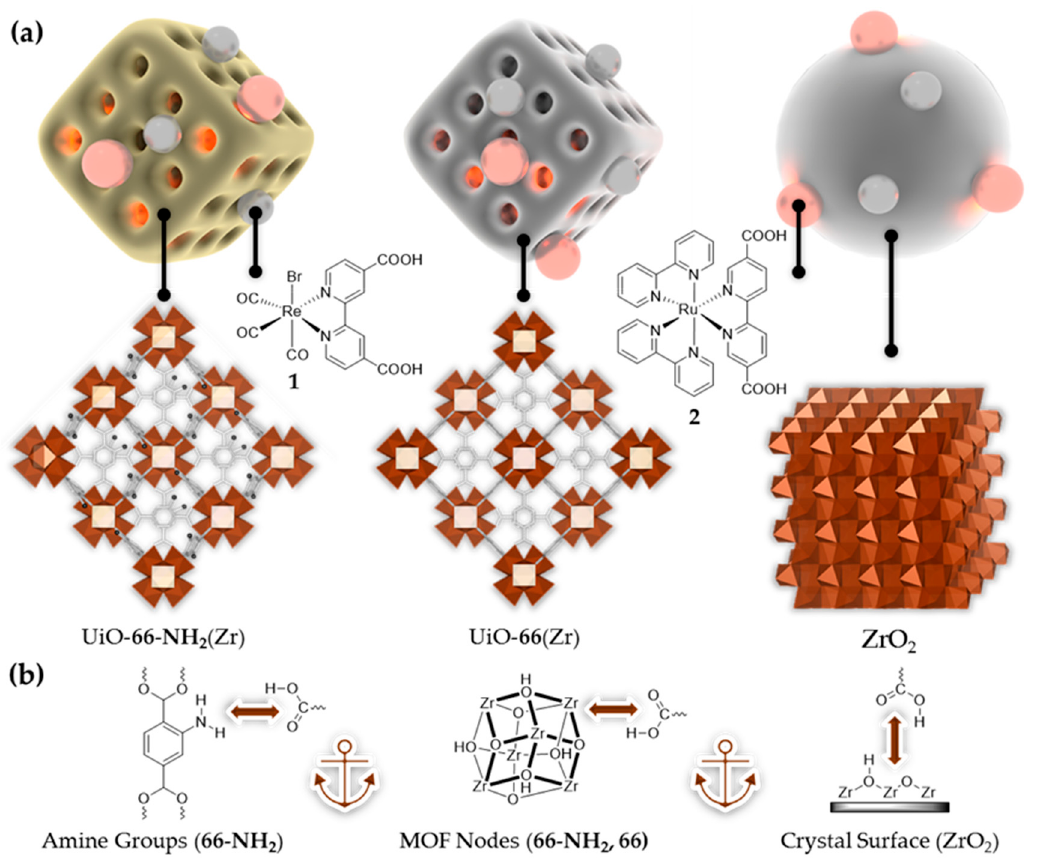
Figure 1. Schematic overview of the studied hosts and molecular complexes. ( a ) Representation of the porous MOF hosts UiO-66-NH 2 (Zr) ( 66-NH 2 ) and UiO-66(Zr) ( 66 ), as well as monoclinic ZrO 2 nanoparticles. Chemical structures of the molecular photocatalyst fac -ReBr(CO) 3 (4,4 ′ -dcbpy) ( 1 ) and the [Ru(bpy) 2 (5,5 ′ -dcbpy)]Cl 2 photosensitizer ( 2 ). ( b ) Anchoring interactions between the molecular species 1 and 2 to 66 , 66-NH 2 and ZrO 2, respectively.